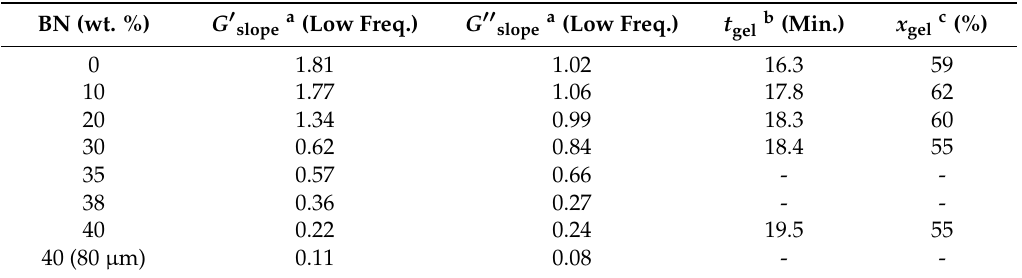
Table 2. Rheological fitting results at 30 ◦ C and gelation data from rheometric monitoring of the curing of the formulations at 85 ◦